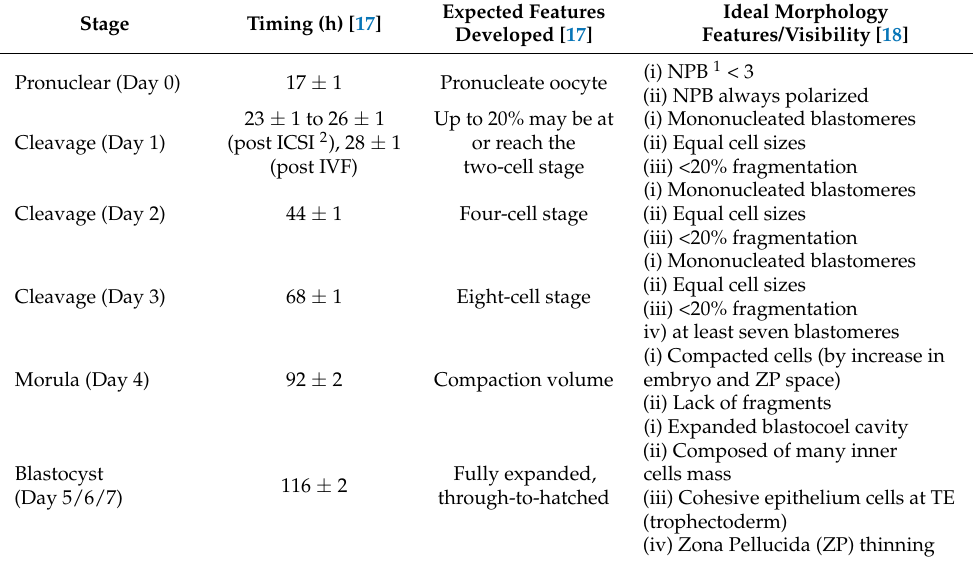
Table 1. Embryo stages and morphological features in IVF process from pronuclear to blastocyst stage of development at each time